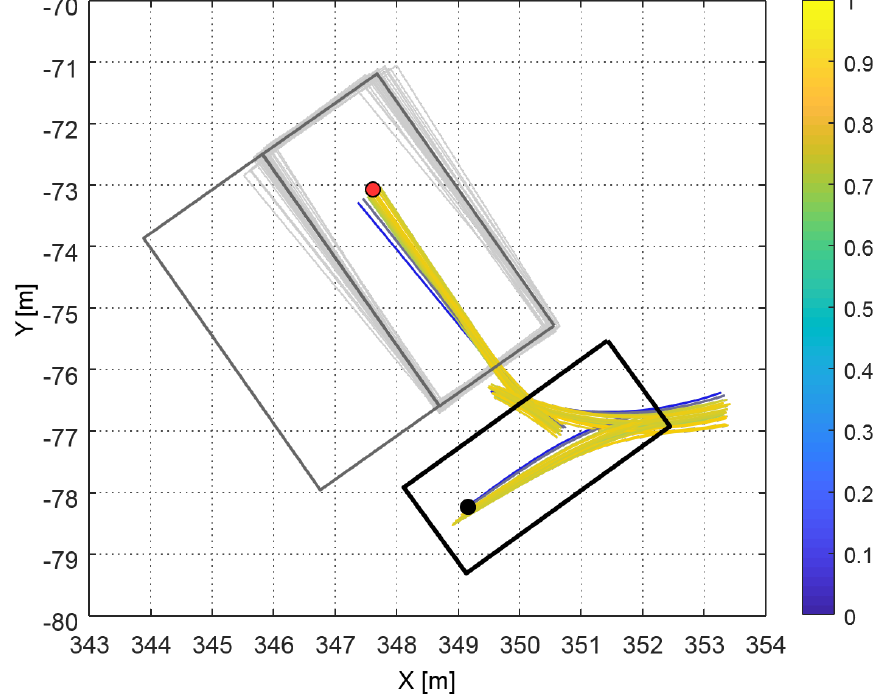
Figure 8. The utility of each path candidate is estimated; the path that is the nearest to the actual target state has the maximum expected